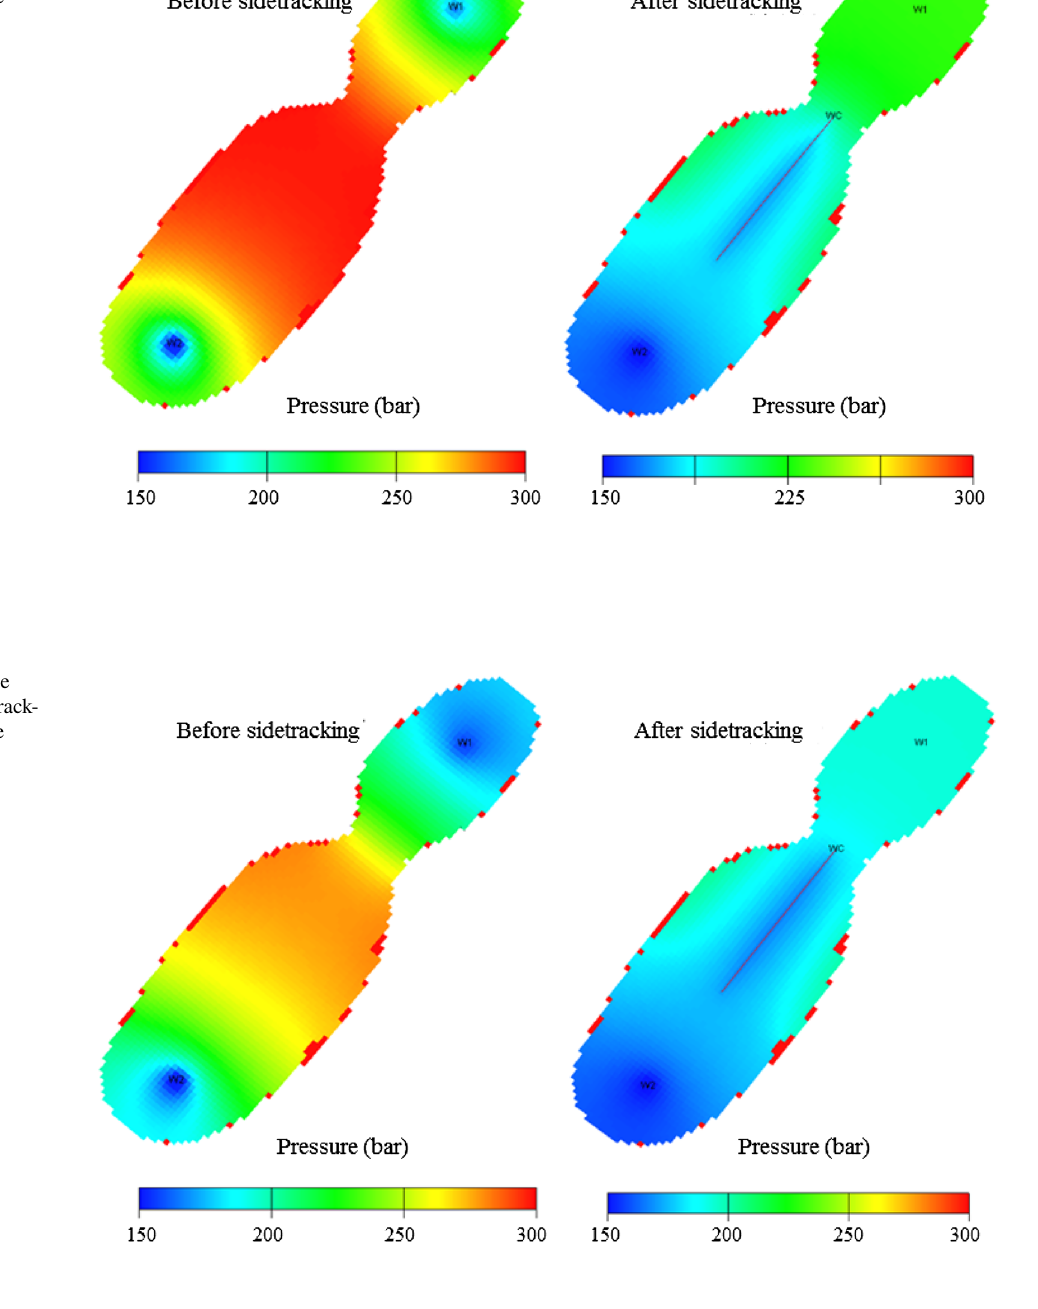
Fig. 7 Pressure conformance status before and after sidetrack- ing (old gas well cumulative production rate when side- tracked is 800 × 10 4 m 3 )